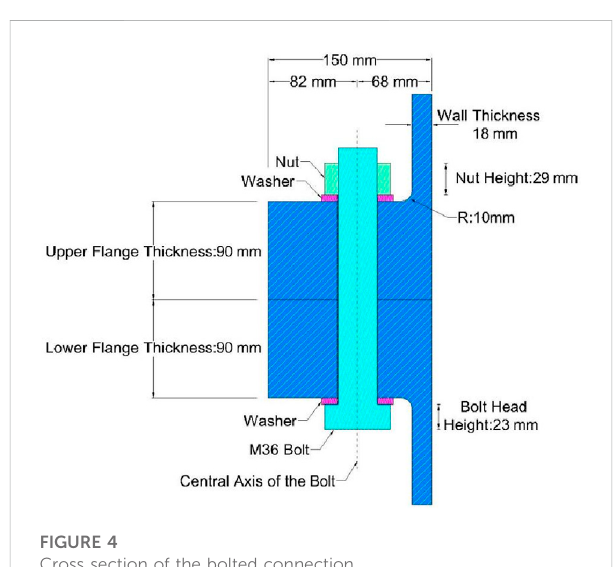
FIGURE 4 Cross section of the bolted